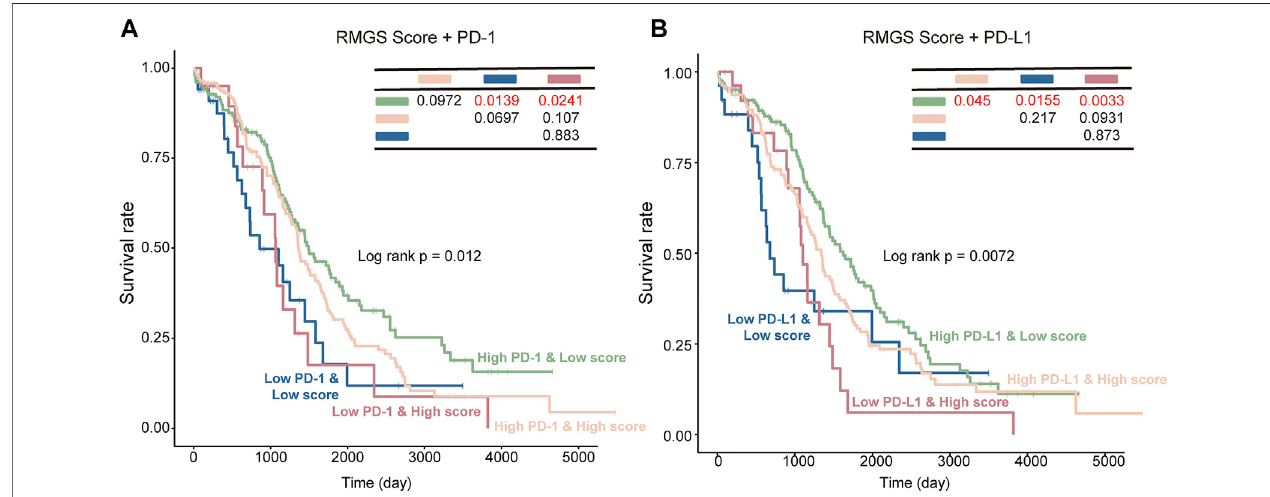
FIGURE5| Kaplan – MeiersurvivalcurvesofOSamongthefourpatientgroupsstrati fi edbytheintegrationoftheRMGSscoreandexpressionlevelsofPD-1 (A) and PD-L1 (B)